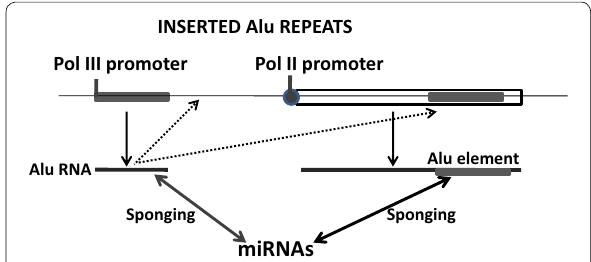
Fig. 3 Role of Alu elements in the regulation of miRNA activity. Shown are nuclear Alu elements transcribed from its own RNA pol III promoter in the case of being independent transcriptional units (left), or from an RNA pol II promoter in the case of being integrated inside another gene. In both cases these can behave as miRNA sponges by interacting with miRNAs. Some individual Alu elements can retroinsert into intergenic regions or inside other transcriptional units (taken from